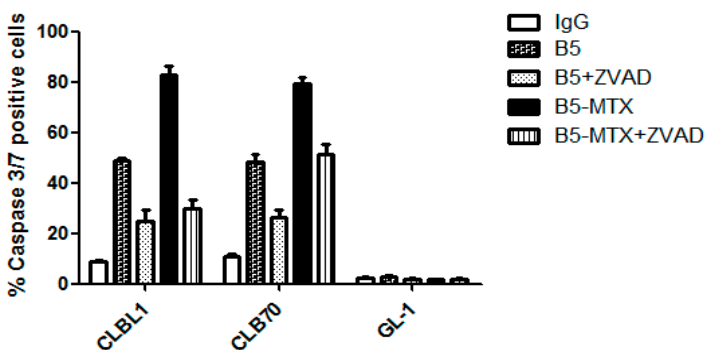
Figure 2. Assessment of caspase 3/7 activation after treatment of individual canine cell lines with